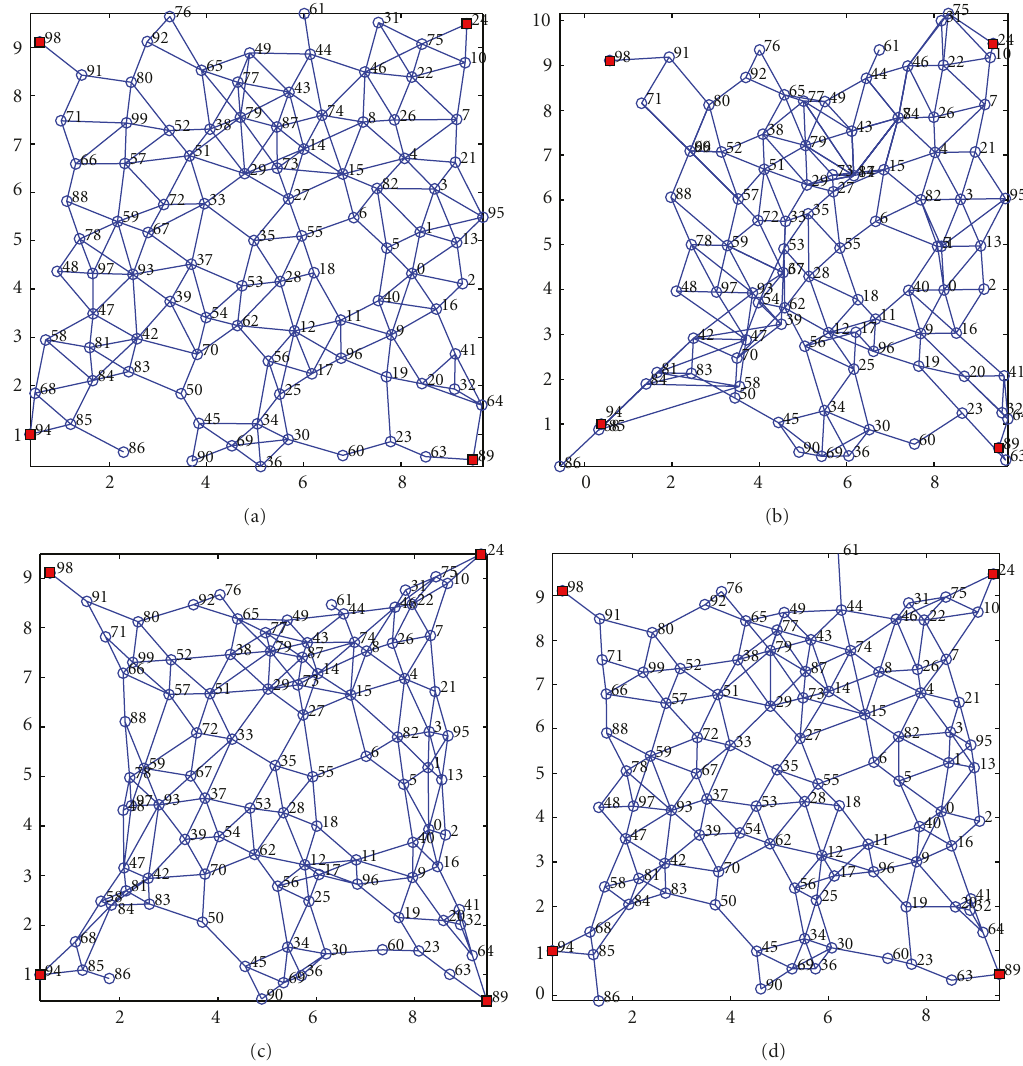
Figure 8: Topology regeneration ( N = 100, G = 4, connectivity = 4.88): (a) actual topology, (b) DV-HOP (error = 0.50), (c) SOM (error = 0.35), (d) LS-SOM (error =